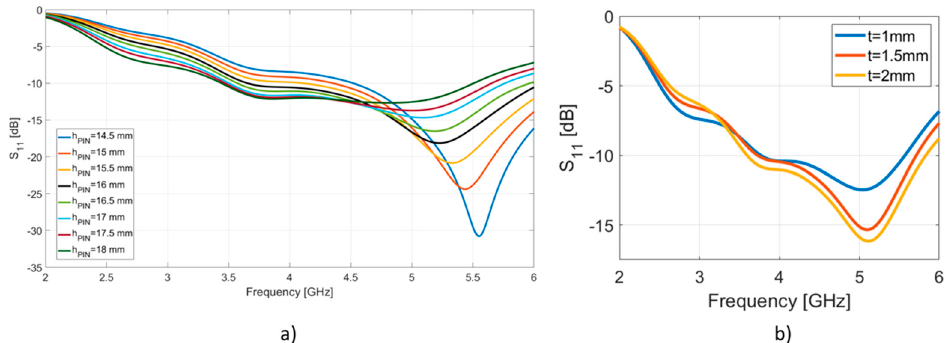
Figure 3. ( a ) Scattering parameter S 11 as a function of the pin height h PIN , by considering the DRA thickness t = 2 mm and h DRA = 29 mm; ( b ) Scattering parameter S 11 as a function of the DRA thickness, considering the pin height h PIN = 17 mm and DRA height h DRA = 29 mm.